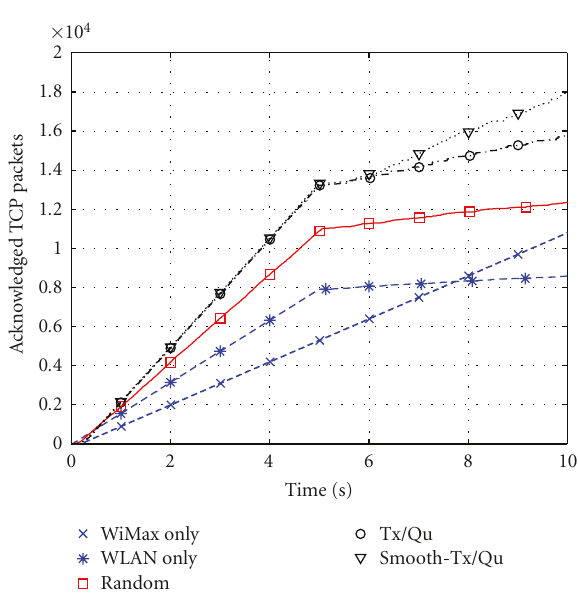
Figure 6: Acknowledged TCP packets of the download performed by one user that instantaneously (after 5 seconds) moves 30m away from colocated WLAN AP and WiMax BS versus time; single WLAN RAT connection, single WiMax RAT connection, and di ff erent distribution strategies are